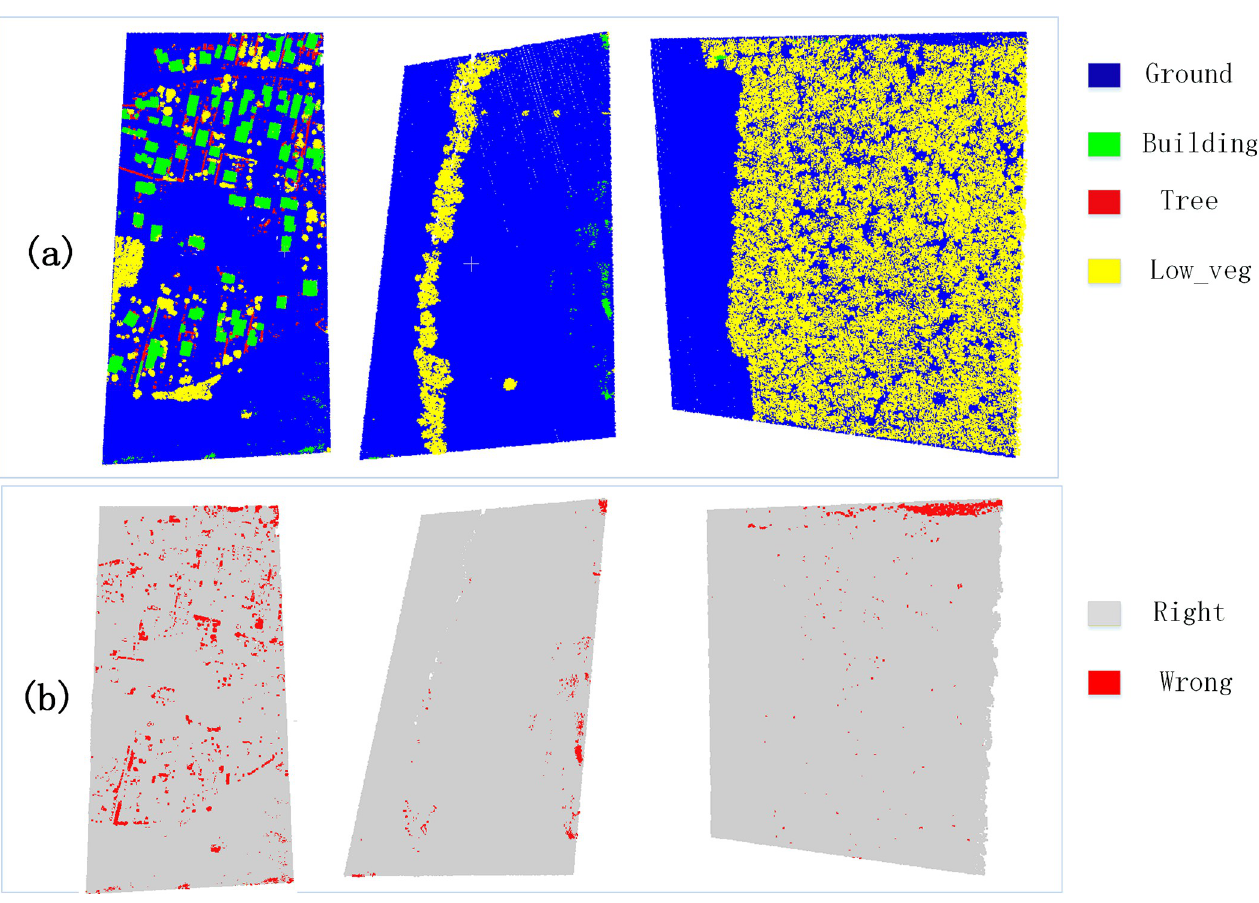
Fig 4. Prediction map (a) and error map (b) of our proposed method on the GML(B) benchmark